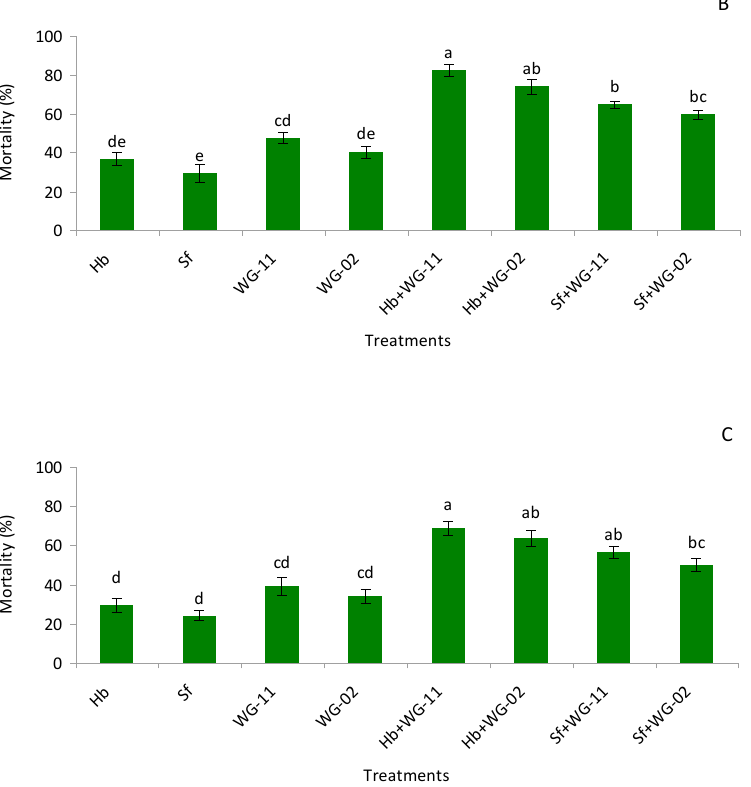
Figure 1. Mean (% ± SE) mortality of pre-pupae ( A ), pupae ( B ) and late last instar larvae ( C ) of Thrips tabaci when treated with Hb = Heterorhabditis bacteriophora , Sf = Steinernema feltiae , WG-11 = Beauveria bassiana (WG-11), WG-02 = Metarhizium anisopliae (WG-02), Hb + WG-11 = H. bacteriophora + B. bassiana , Hb + WG-02 = H. bacteriophora + M. anisopliae , Sf + WG-11 = S. feltiae + B. bassiana , Sf + WG-02 = S. feltiae + M. anisopliae in a laboratory small cup bioassay. Different letters above the bars indicate statistical significance ( p < 0.05; Tukey’s test). Table 1. Interactions between Heterorhabditis bacteriophora (Hb), Steinernema feltiae (Sf), Beauveria bassiana (WG-11), and Metarhizium anisopliae (WG-02) against late second instar larvae, pre-pupae, and pupae of Thrips tabaci in a laboratory small cup bioassay. Stage